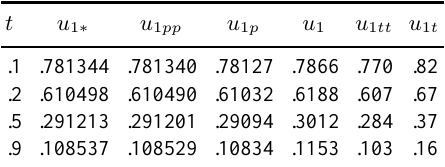
Table 1. The values u (1 ; t ) at different time t moments.